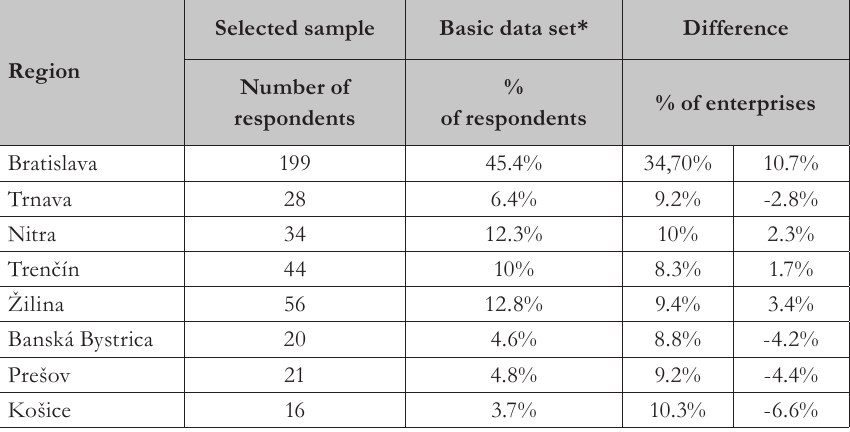
Tab. 2 - Comparison of the regional structure (basic data set and selected